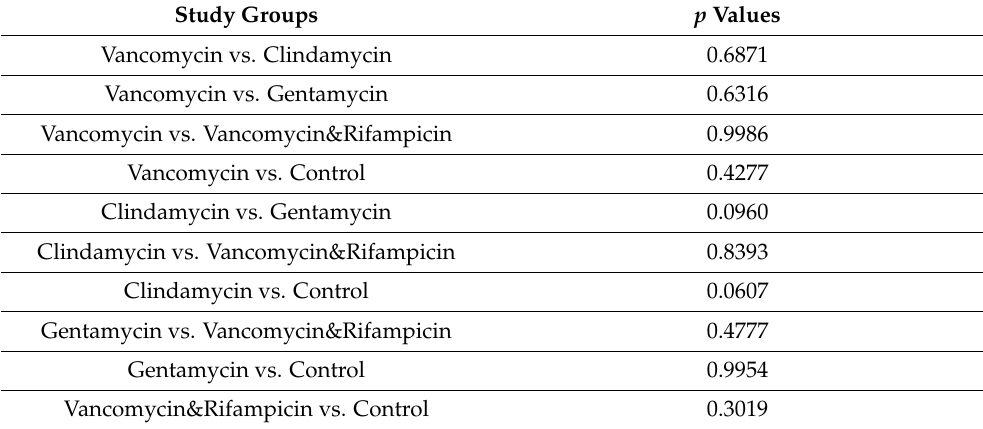
Figure 6. Percentages of bone formation in the different study groups at 120 days post implantation. New bone formation was calculated in relation to the total implant area (in %, displayed as mean ± standard deviation). Table 1. p values of the statistical comparison.